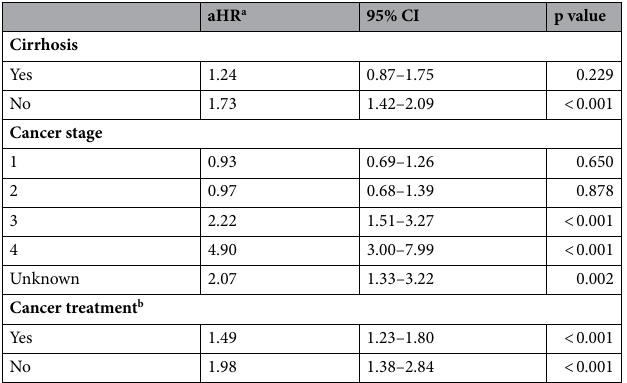
HCC cohort Cancer-free cohort